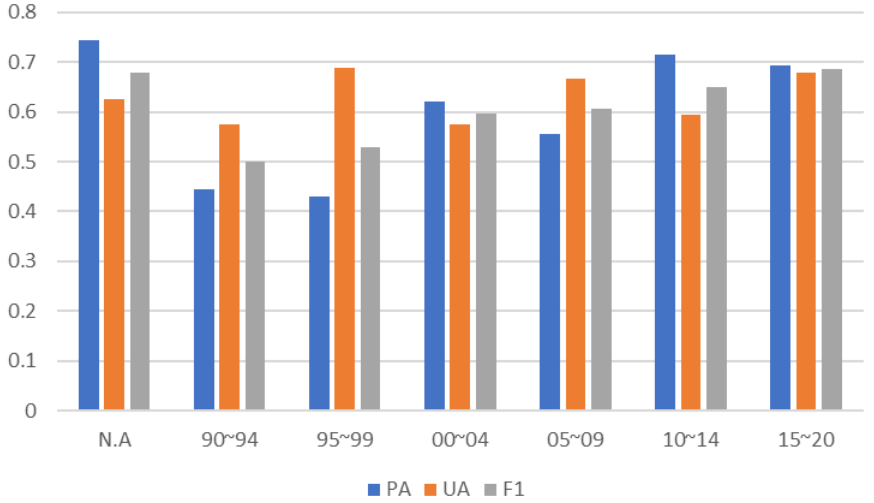
Figure 11. Classification performance of non-abandoned (N.A) and abandoned croplands grouped by abandonment date, indicated by producer accuracy (PA), user accuracy (UA), and F1 score. ‘90~94’ represent croplands abandoned during 1990 and 1994, etc.